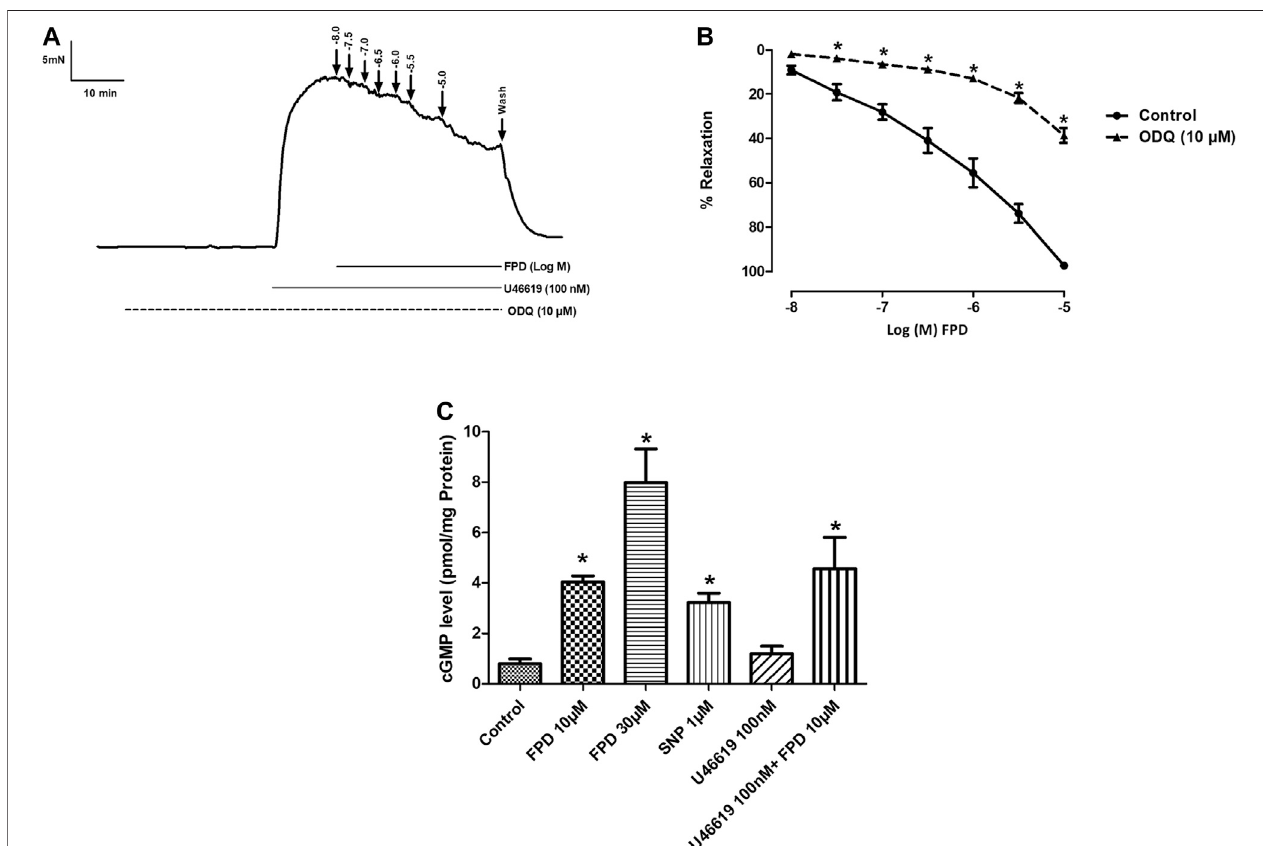
FIGURE 5 | Traces showing FPD-induced concentration dependent relaxation in rat superior mesenteric arterial rings pre-incubated with ODQ (10 µM) for 20 min andpre-constrictedwithU46619(100 nM) (A) .ConcentrationresponsecurveofFPDinthepresenceofODQ(10 µM) (B) .Relaxationisexpressedasthemean ± S.E.M. ( n (cid:2) 6) percentage reversal of contraction. The bar diagram (C) depicts the mean intracellular cGMP level in treated rat superior mesenteric arterial tissues. Vertical bar represents mean ± S.E.M. ( n (cid:2) 6; * p < 0.05 compared to control).